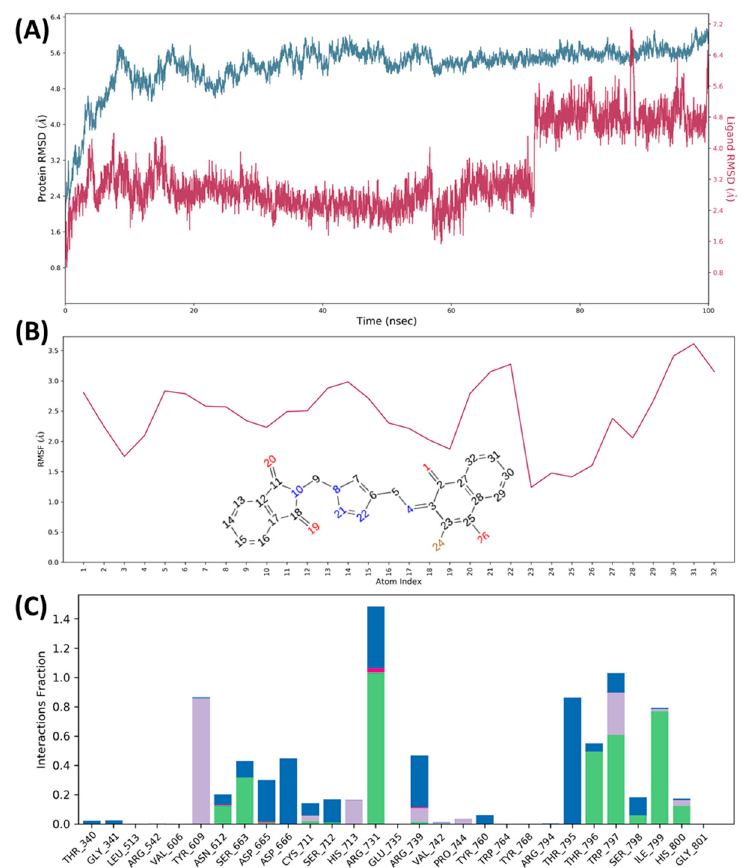
Figure 9. Molecular dynamics of 4b -RdRp (5U04) complex. ( A ) RMSD plot obtained for protein C α and compound 4b shown in blue and red colour, respectively; ( B ) Ligand RMSF-fluctuations of each atom of compound 4b with respect to the protein; ( C ) Histogram plot showed interacting residues with compound 4b during MD simulation (H-bond: green, hydrophobic: grey, salt bridge interaction: pink, and water bridge interaction: blue).